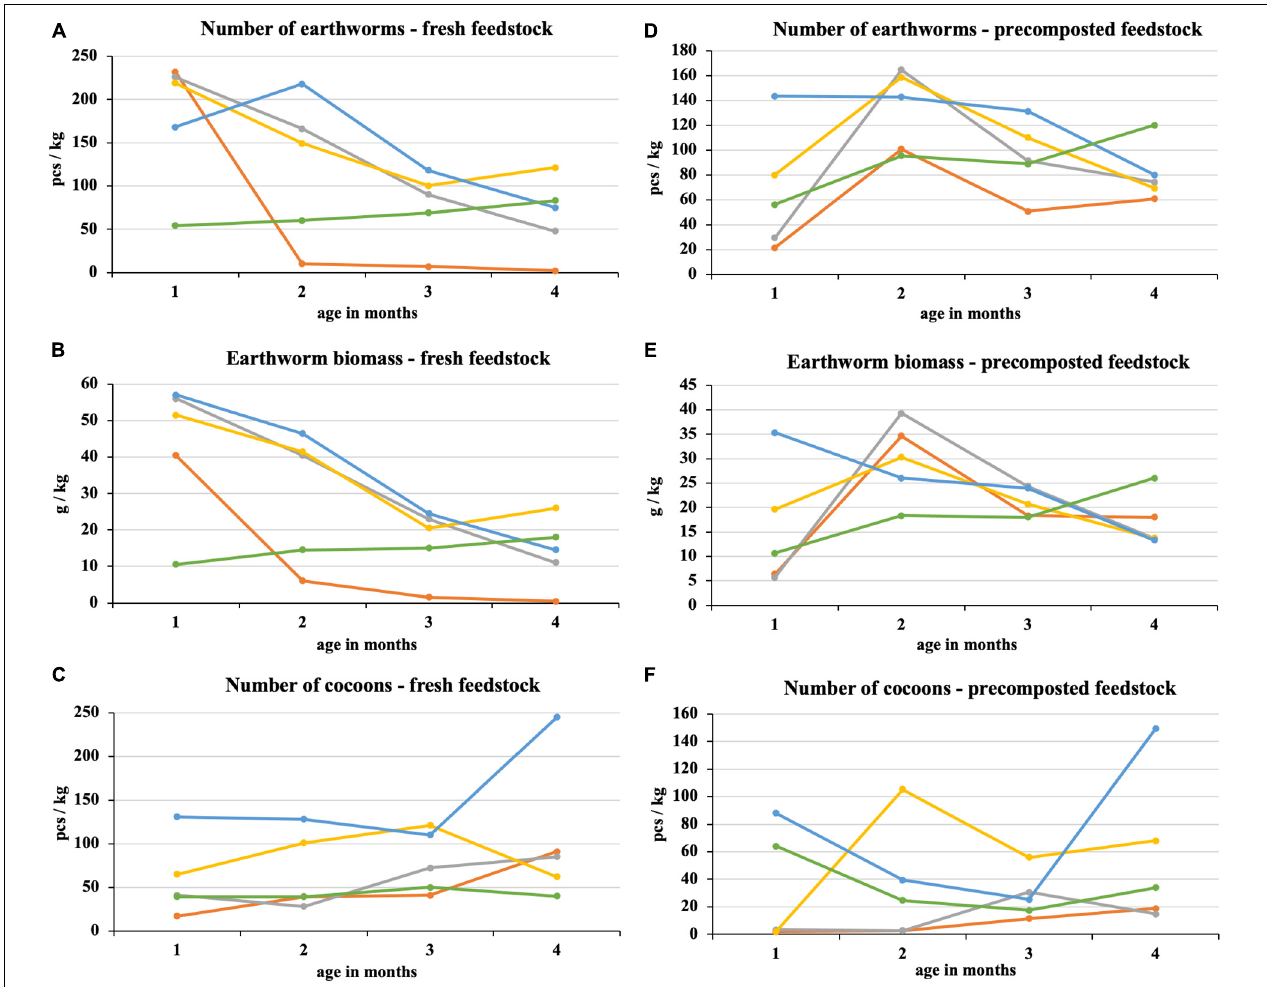
FIGURE 4 | Course of number of earthworms, earthworm biomass, and number of cocoons in treatments with vermicomposting of fresh feedstock ( A–C ) and with vermicomposting of precomposted feedstock ( D–F ). , sludge 100% with earthworms; , sludge 75% + PWS 25% with earthworms; , sludge 50% + PWS 50% with earthworms; , sludge 25% + PWS 75% with earthworms; , PWS 100% with earthworms; PWS, pelletized wheat